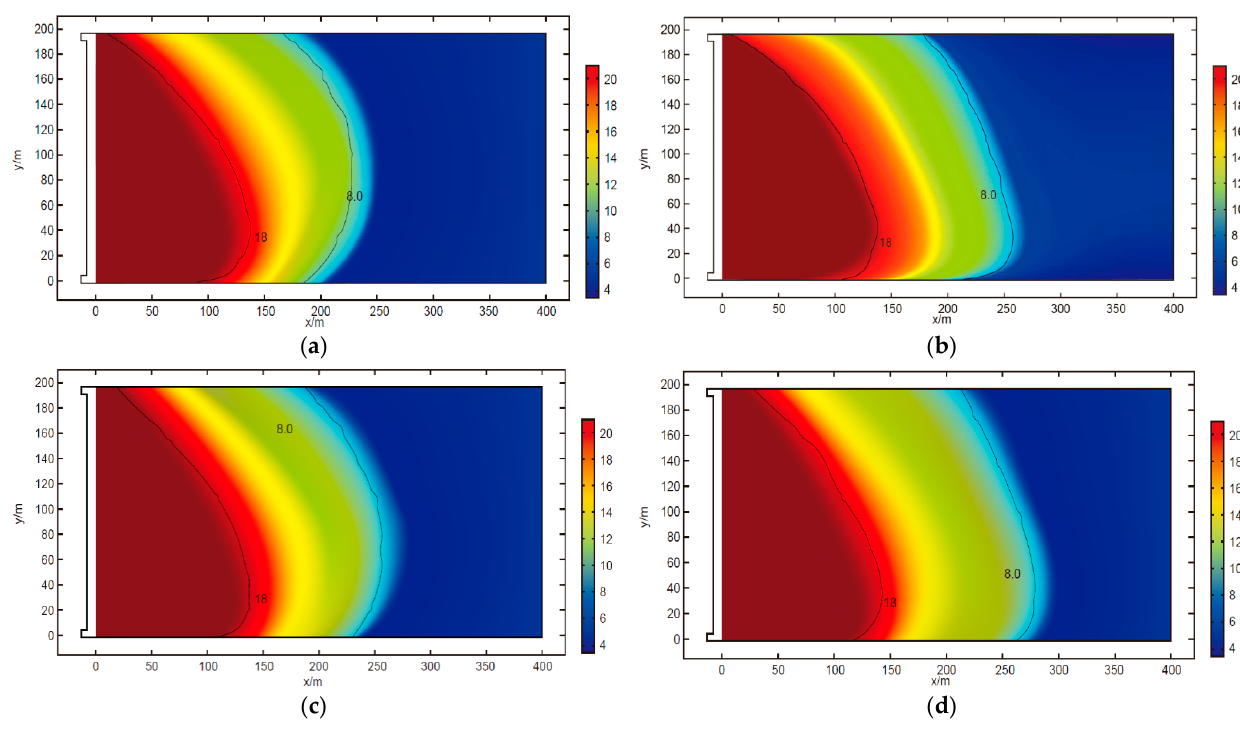
Figure 6. Oxygen concentration contours with different air volumes. ( a ) 500 m 3 /min (equals to a wind speed of 0.98 m/s), ( b ) 900 m 3 /min (equals to a wind speed of 1.48 m/s), ( c ) 1300 m 3 /min (equals to a wind speed 2.08 m/s), ( d ) 1900 m 3 /min (equals to a wind speed 3.12 m/s). Based on the obtained results, variations of the three zones were analyzed after adjusting the air volume and reaching steady-state conditions. Table 4 shows SC